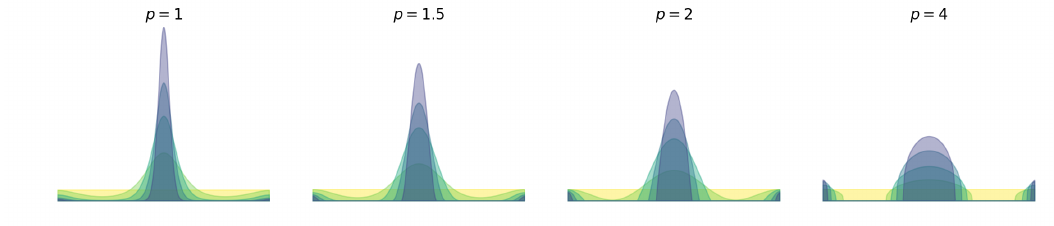
Figure 3 Behavior of Algorithm 1 (PGM) for a nonnegative sparse deconvolution problem with solution µ ∗ = δ 0 , with d = 1 and for various Bregman divergences η p ( p = 1 stands for η ent ). We plot the function f k for k ∈ { 0 , 6 , 6 2 , 6 3 , 6 4 } , we use the same step-size and the same axes in all cases. The associated convergence plots are in Figure 4.